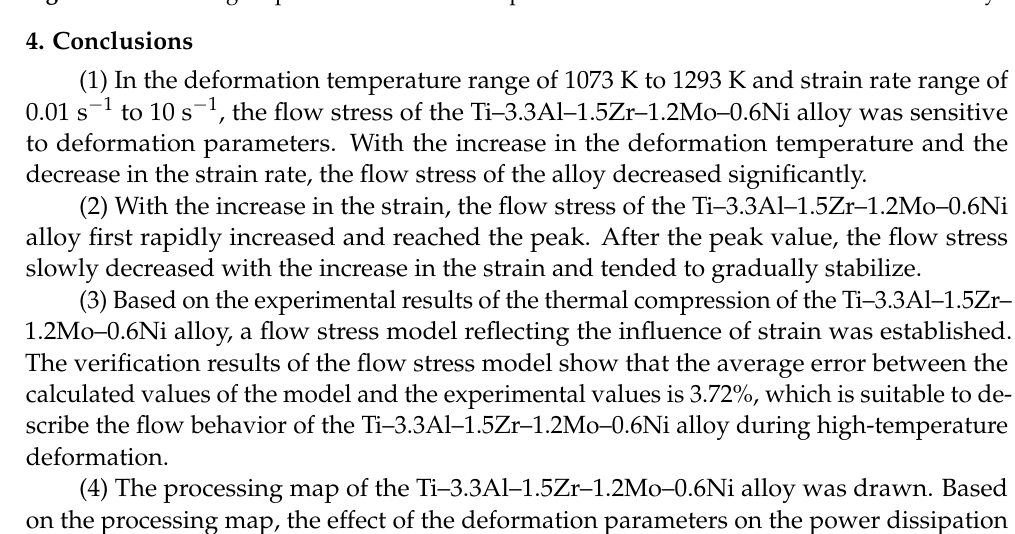
Figure 14. Processing map of the isothermal compression of the Ti–3.3Al–1.5Zr–1.2Mo–0.6Ni alloy.